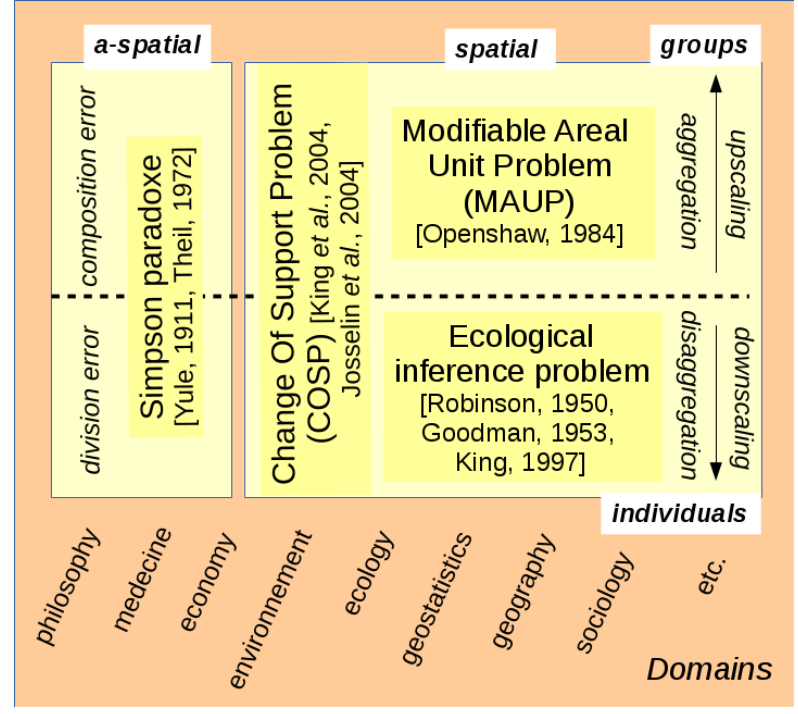
Figure 1. Around the Modifiable Areal Unit Problem